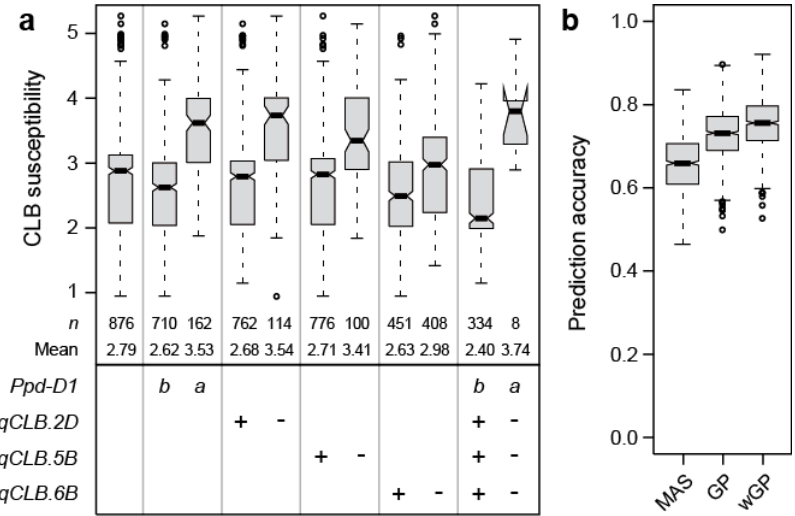
Figure 4. ( a ) Boxplots showing the effects of individual QTL (qCLB), explaining more than 4% of the genotypic variance, as well as the combination of their resistant ( + ) or susceptible (-) alleles on cereal leaf beetle (CLB) susceptibility. For Ppd-D1 , b refers to the wild-type allele and a to the photoperiod- insensitive allele, ( b ) Boxplots showing the prediction accuracy for marker-assisted selection (MAS), based on the two markers significant at the Bonferroni corrected threshold ( Ppd-D1 , qCLB.2D ), compared to genomic prediction (GP), or a weighted genomic prediction (wGP) that incorporates the two markers as fixed effects.